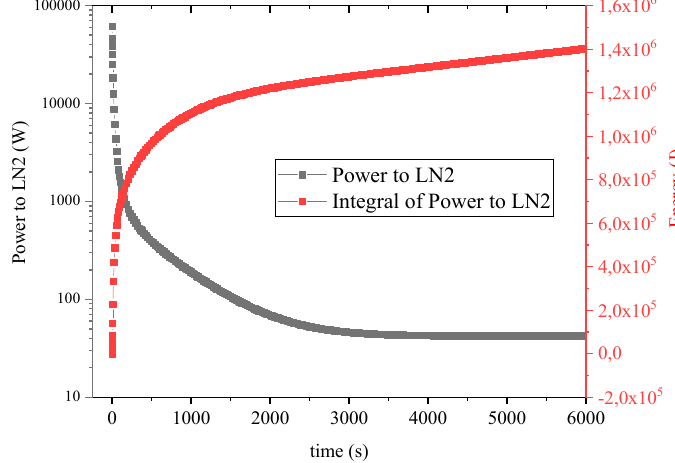
Figure 8. Heat power transferred to LN 2 through the vessel inner bottom surface.